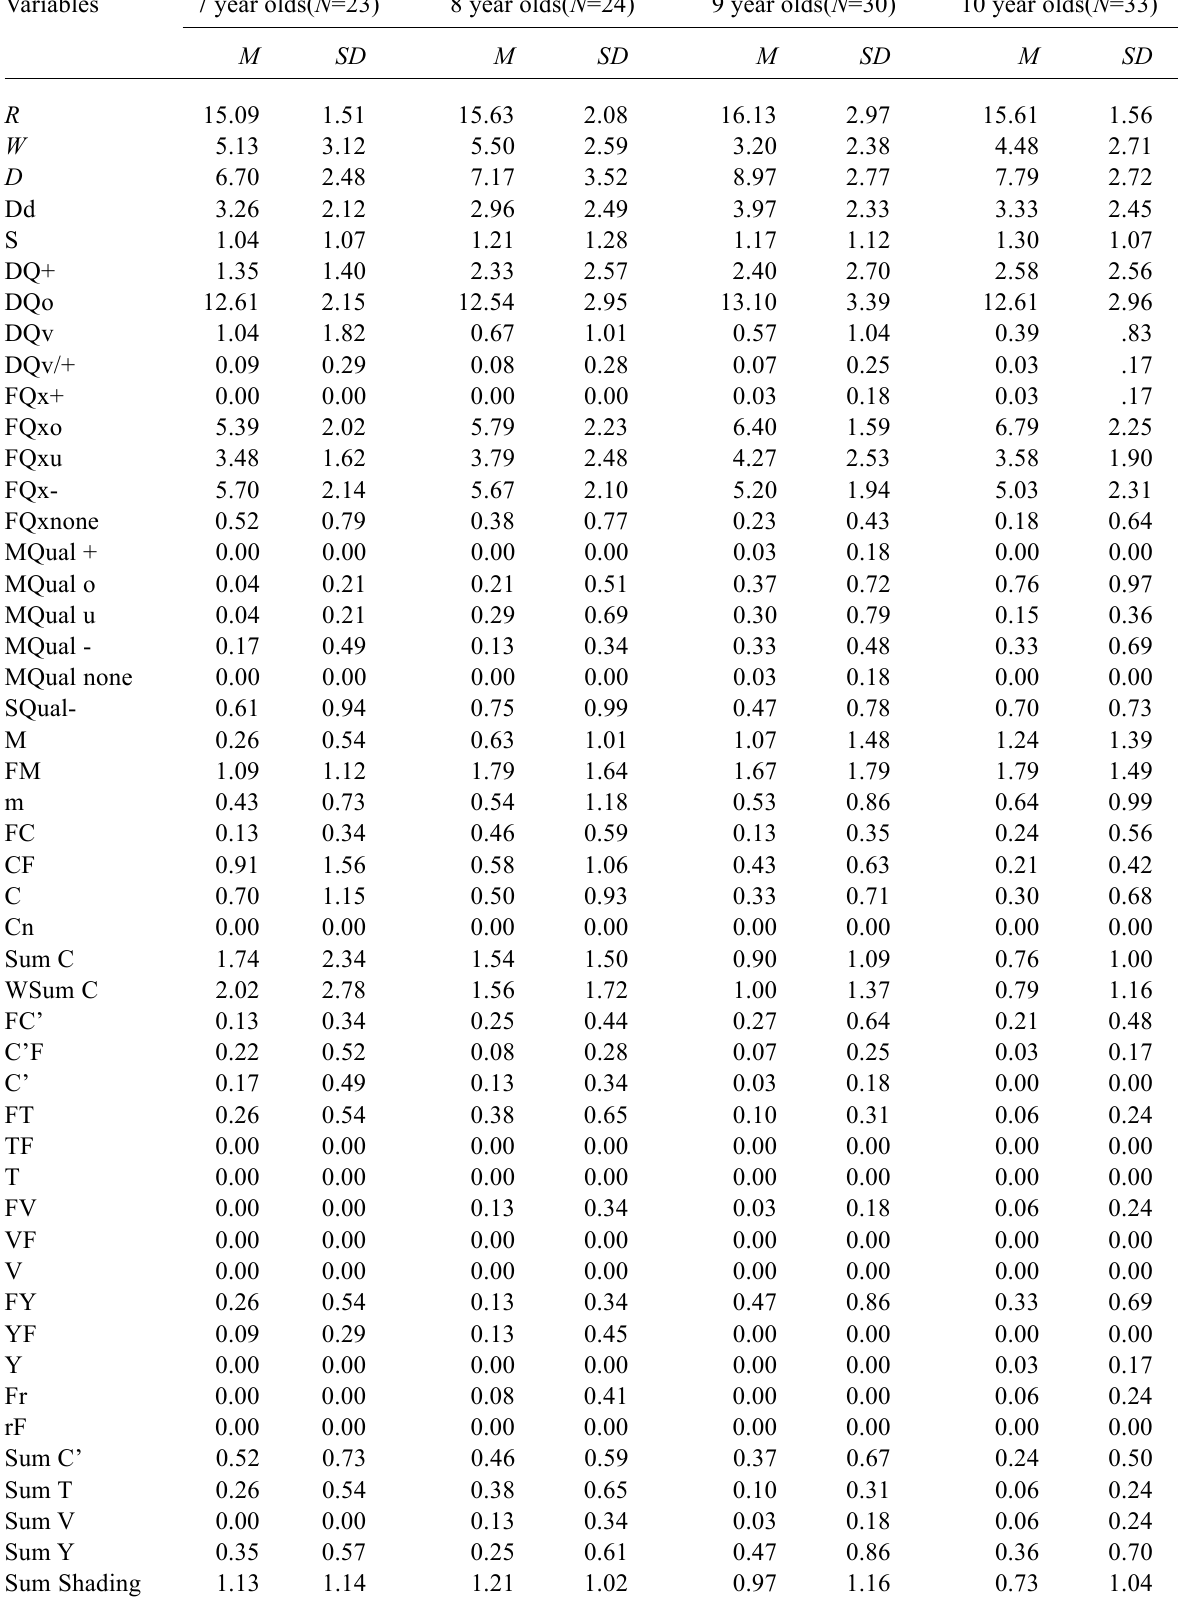
Statistical Distribution of the 113 Rorschach Variables of Children from Public Schools (N = 101)